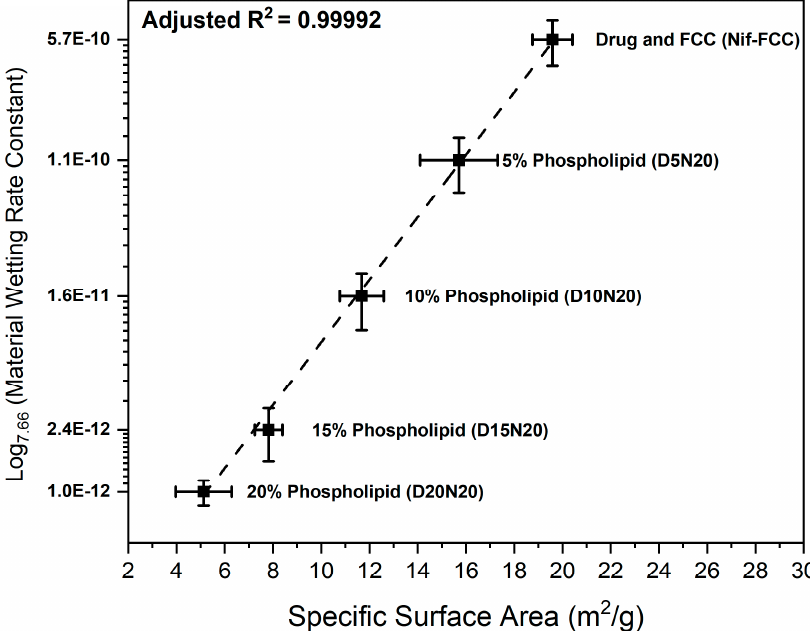
Figure 6. The semi-logarithmic plot (base 7.66) of the correlation between the wetting constants versus specific surface area of the powder samples.